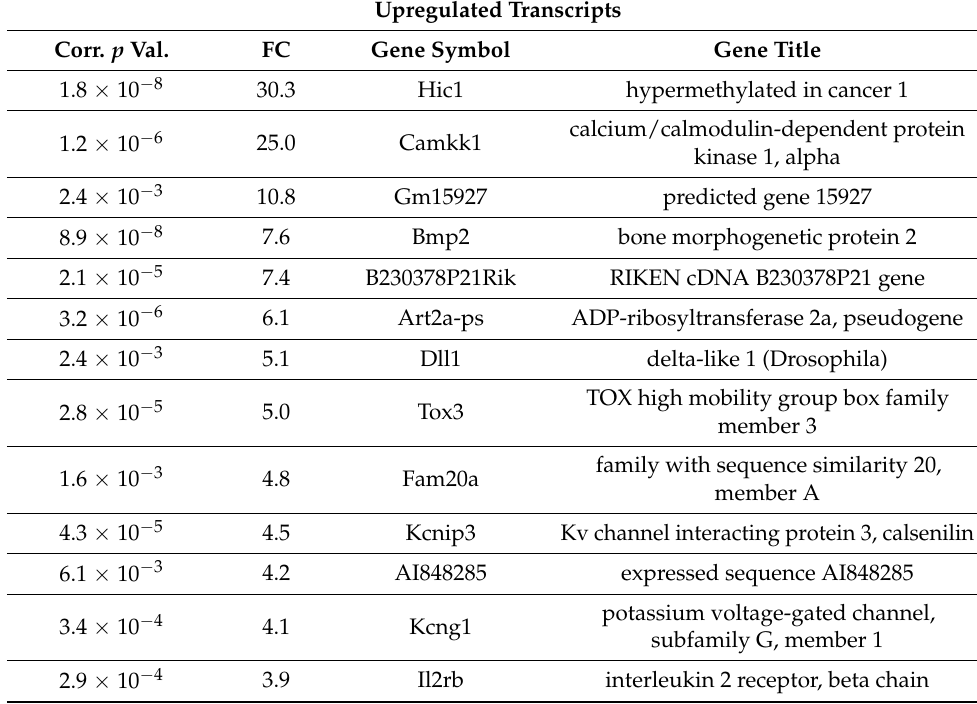
Table 2. List of 106 differentially expressed transcripts between 2 h DMSO- and 2 h DHR (1 µ M)-treated 4 days differentiated macrophages (based on at least 1.5-fold change and corrected p value <